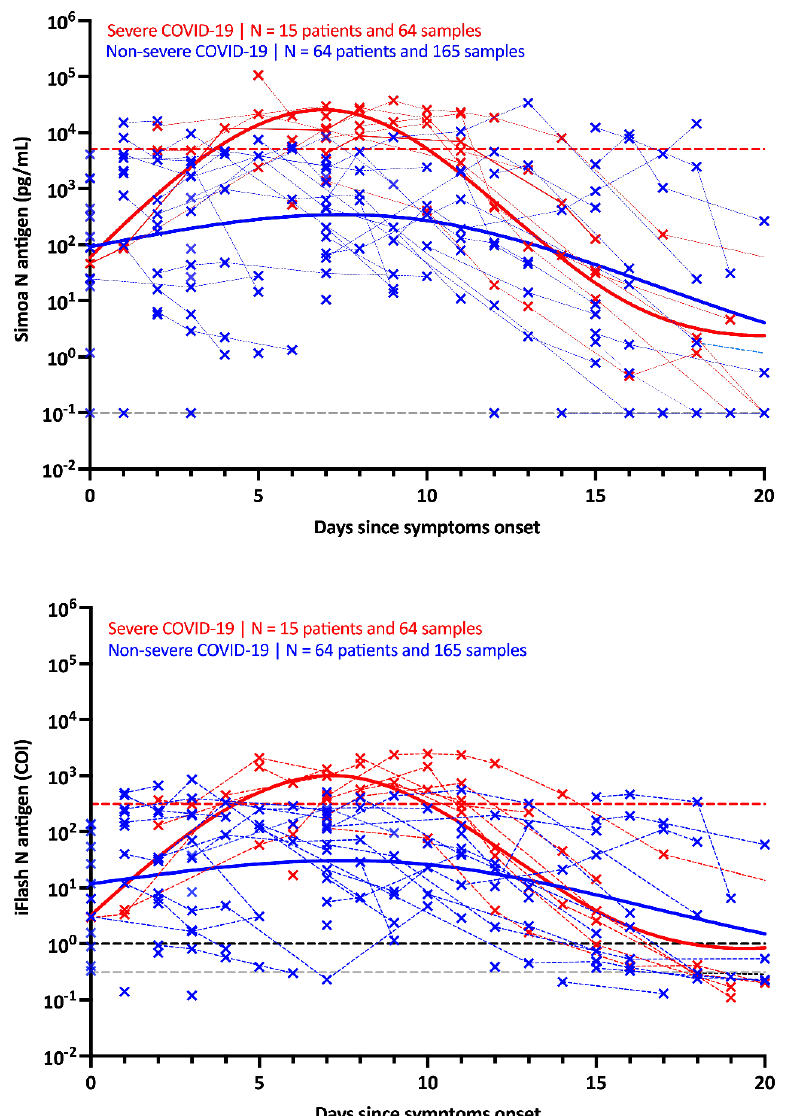
Figure 2. Kinetics of antigenemia since the onset of symptoms in non-severe and severe patients. The grey dotted lines correspond to the positivity cut-off of each antigen assay, as found by ROC curve analyses. The black dotted line corresponds to the positivity cut-off of the iFlash assay, as declared by the manufacturer. The red dotted lines correspond to the severity cut-off of each antigen assay, as found by the ROC curve analyses for the day 2–day 14 window. Only patients with symptoms and negative for SARS-CoV-2 Spike IgG directed against the spike protein were included in this kinetics representation.